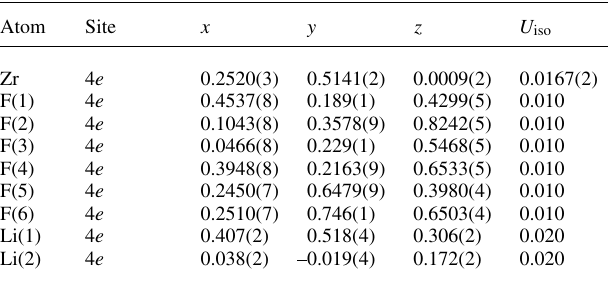
Table 2. Atomic coordinates and displacement parameters (in Å 2 )